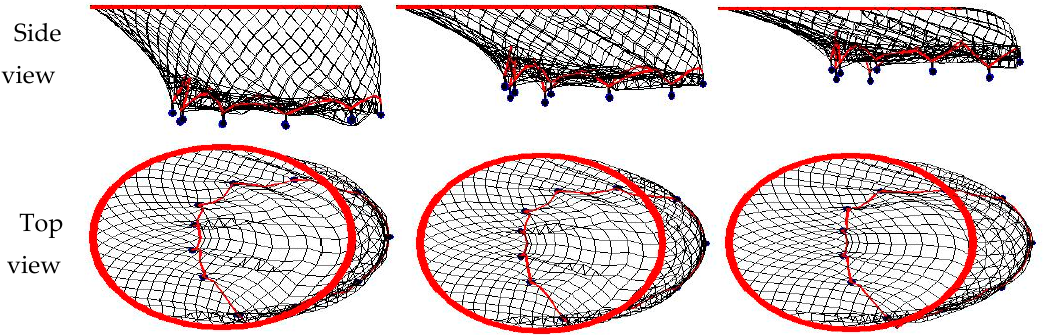
Figure 6. Equilibrium geometry of the net cage at current speeds of 20, 30, and 40 cm/s.